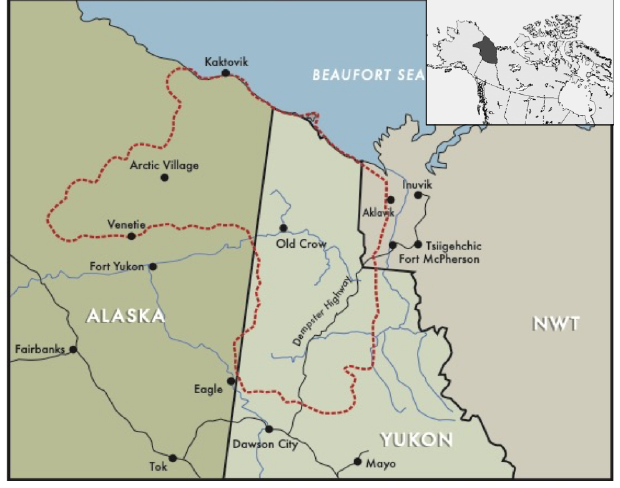
Fig. 2 . The range (red outline) of the Porcupine Caribou Herd in Alaska, Yukon, and Northwest Territories, showing the 1002 area (blue outline) of the National Arctic Wildlife Refuge.